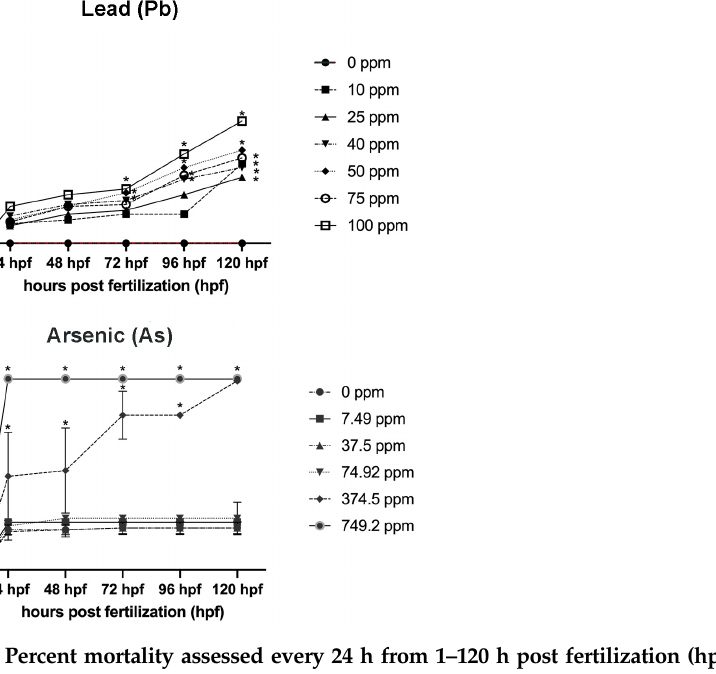
Figure 2. Percent mortality assessed every 24 h from 1–120 h post fertilization (hpf) for Pb and As. Single chemical exposures for Pb ( A ) and As ( B ). N = 4 biological replicates for each treatment group with 50 subsamples per each treatment group. Data is presented as mean ± standard deviation. * p < 0.05.